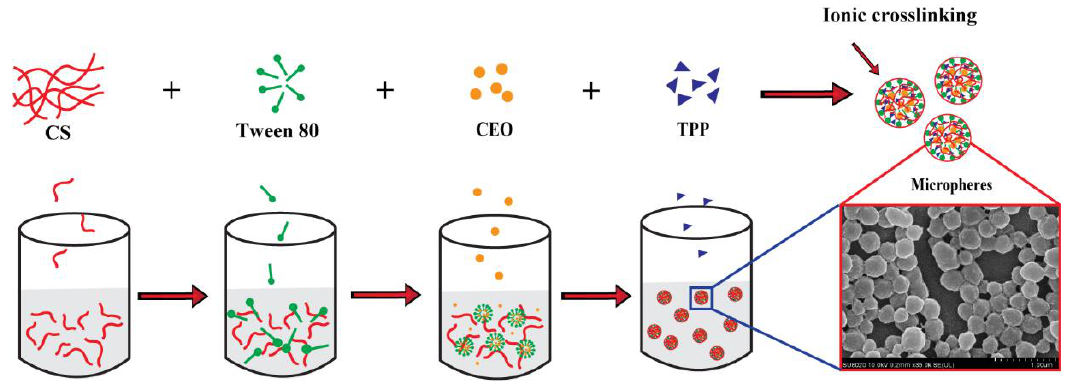
Figure 1. Process of preparing CS-CEO .